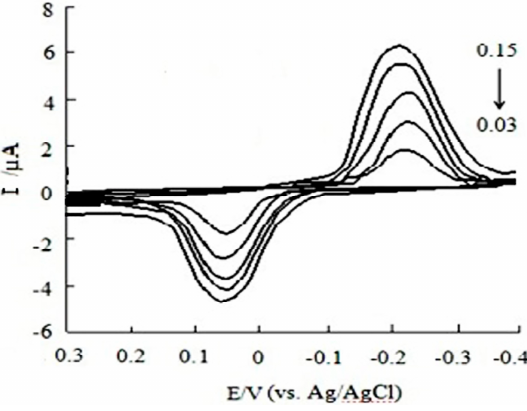
Figure 7. Cyclic voltammetry curves of CGA at different scan rates.